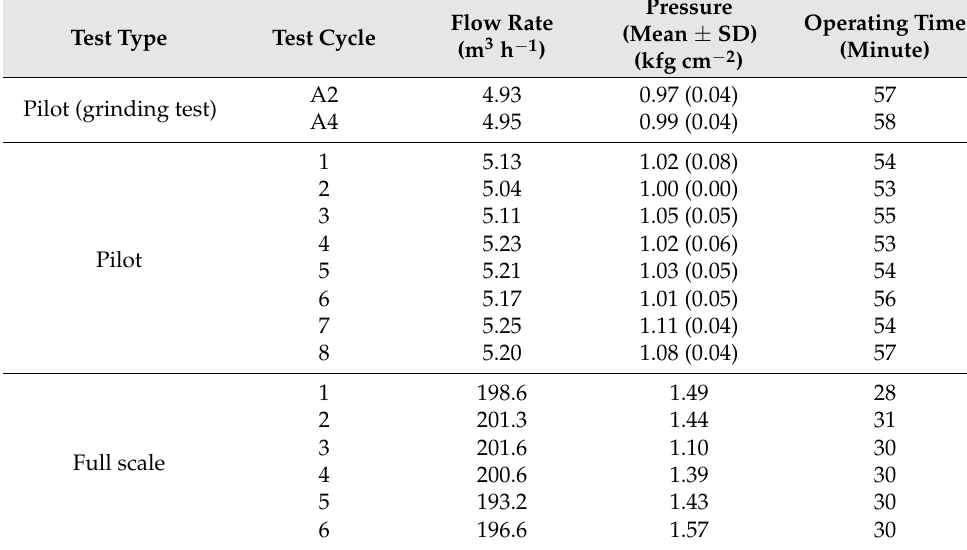
Table 3. Summary of operation parameter for biological efficiency